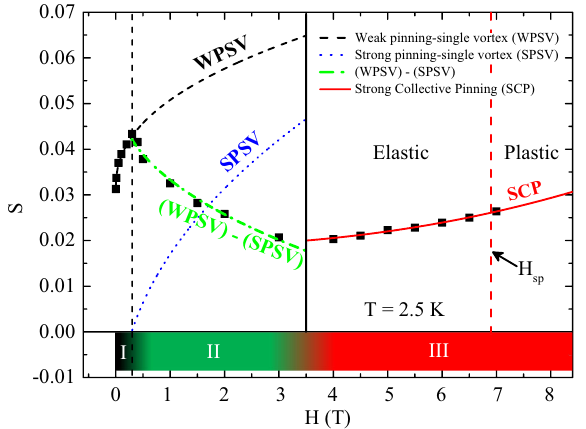
Figure 3. S as a function of H at T = 2.5 K. The black dashed line is the fit of the first S(H) increase with Eq. (1). The blue dotted line is the strong pinning single vortex behavior speculated for the vortices that enter in the twin boundaries using Eq. (1). The green dashed-dotted line is the fit of the decreasing S(H) data with the equation described by the subtraction of the black and blue line. The red solid line is the fit of the second S(H) increase with Eq. (1). In the bottom of the figure, the field intervals relative to the three S(H) portions are identified with different colours. Finally, the black vertical solid line separates the single vortex state from the collective pinning state while the red vertical dashed line, individuated by the H sp value, separates the elastic regime from the plastic regime in the framework of the collective pinning